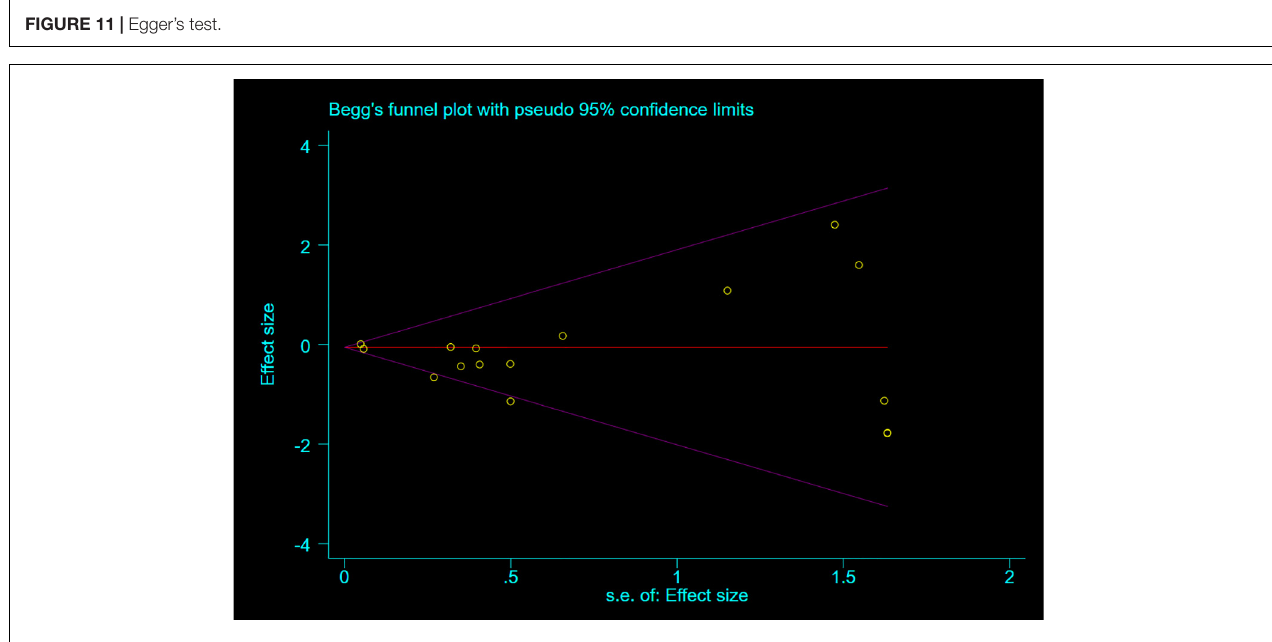
FIGURE 12 | Begg’s